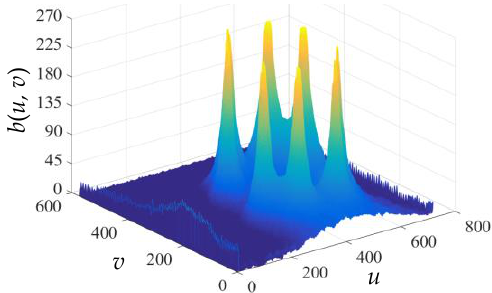
Figure 3. Three-dimensional surface of component B.